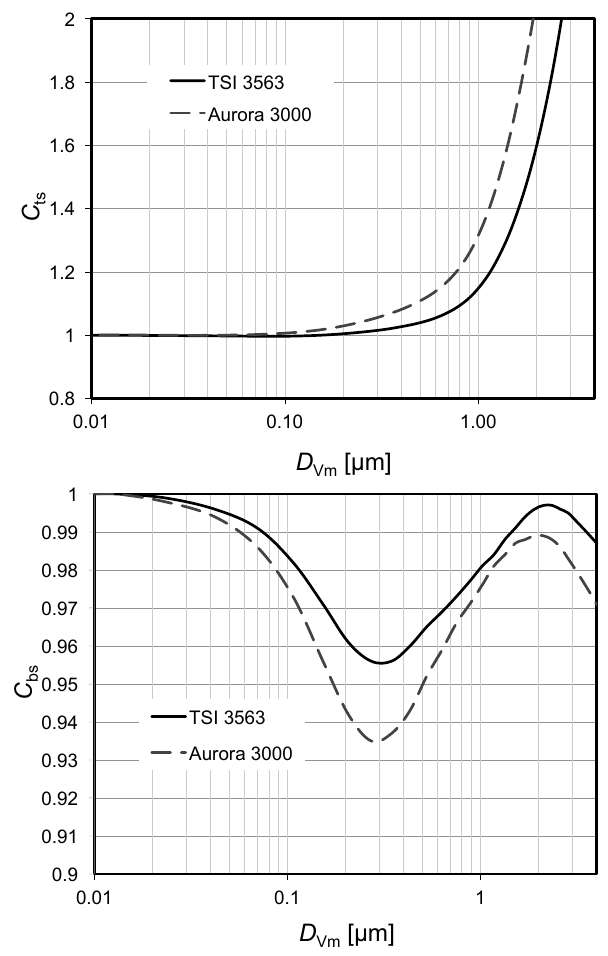
Fig. 4. Angular sensitivity correction factors for total scattering (upper panel) and backscattering (lower panel) versus the volume median diameter of a lognormal volume size distribution with ge- ometric standard deviation 1.6. The refractive index of the aerosol was chosen to be 1.53–0.01 i . The wavelength for calculating cor- rection factors were 525 and 550nm for Aurora 300 and TSI 3563, respectively.